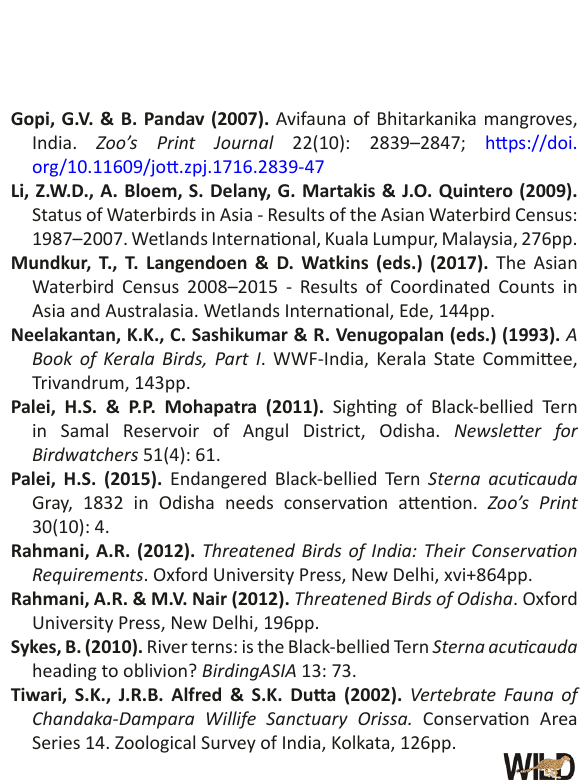
Image 4. Flooded nest (A) and egg (B) of the Black-bellied Tern due to the rise in water level along the Mahanadi River near Mundali in Odisha, eastern